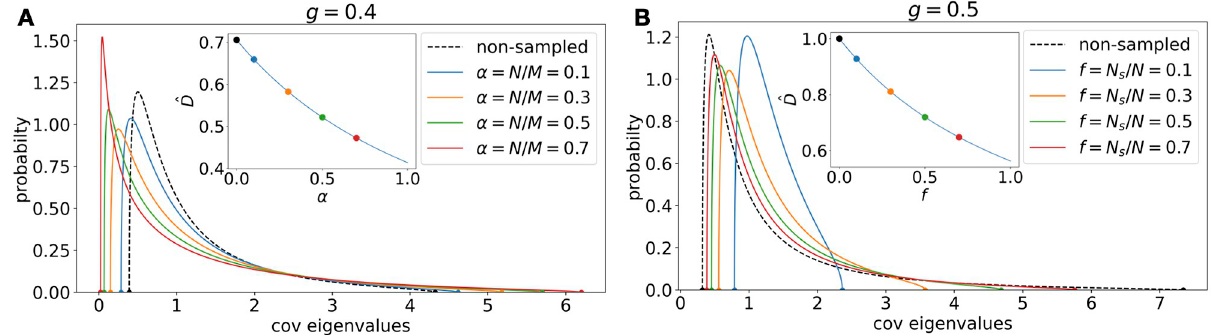
Fig 7. Effects of sampling in time and space on the covariance spectrum. A . For the i.i.d. Gaussian random connectivity, how different levels of time samples α change the spectrum (Eq (22)). The non-sampled case corresponds to α = 0. g is fixed at 0.4. Inset: The relative dimension ^ D vs. α (Eq 23). The dots correspond to the pdfs with matched colors. B . Same as A. but for the spatial subsampling (Section I.2 in S1 Text), at g = 0.5. The non-sampled case corresponds to f = 1. The relative dimension in the inset is based on Section I.1 in S1 Text.